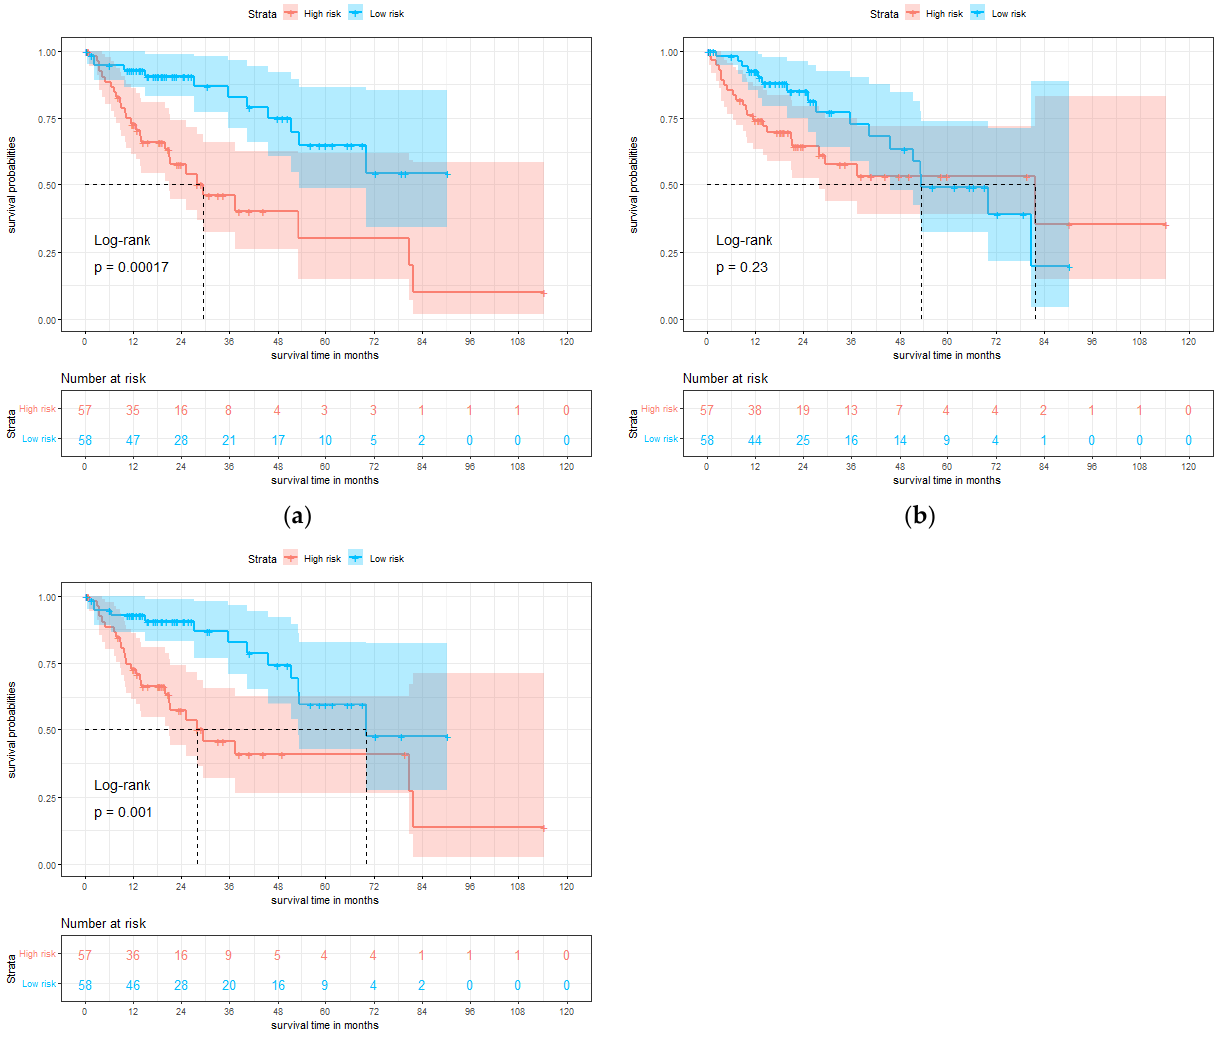
Figure 4. Single-modality and multi-modality models were tested on the test set for hepatocellular carcinoma (HCC). ( a ) Kaplan-Meier (KM) curves of overall survival with the prediction of pathology prognosis model ( p = 0.00017, two-sided log-rank test). ( b ) KM curves of overall survival with the prediction of gene prognosis model ( p = 0.23, two-sided log-rank test). ( c ) KM curves of overall survival with the prediction of multi-modality prognosis model ( p = 0.001, two-sided log-rank test). Red and blue plots represent high-risk and low-risk groups, respectively.